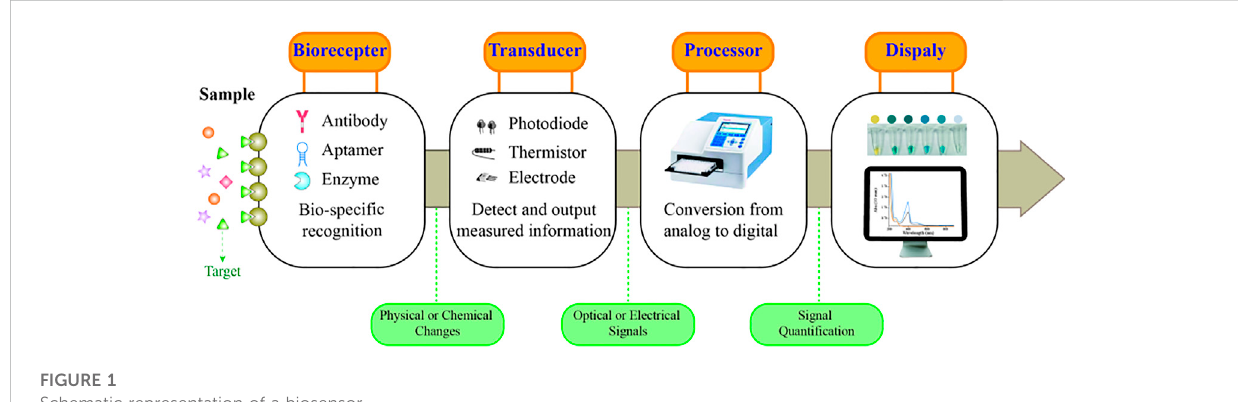
FIGURE 1 Schematic representation of a